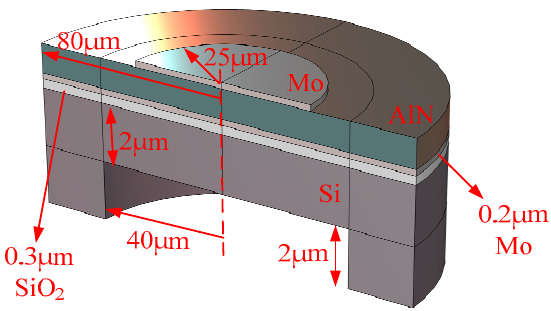
Figure 2. Illustration of a symmetrical section of the PMUT 3D